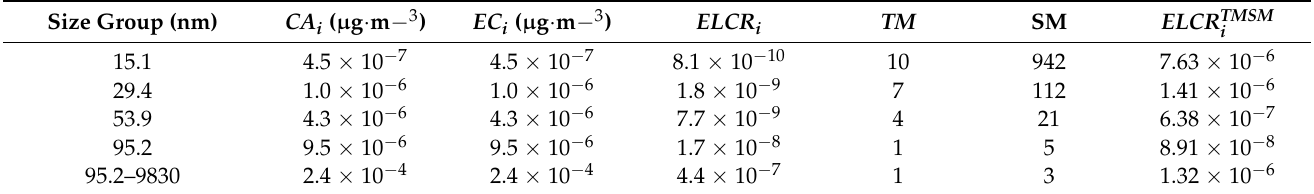
Table 3. Input data for health risk